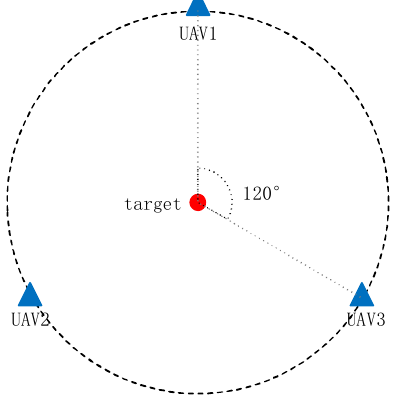
Figure 2. Information fusion structure.